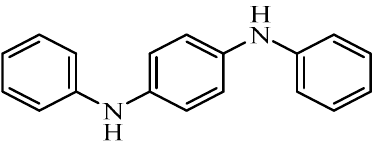
Figure 1. Antioxidants N , N ′‐ diphenyl ‐ 1,4 ‐ phenylenediamine.